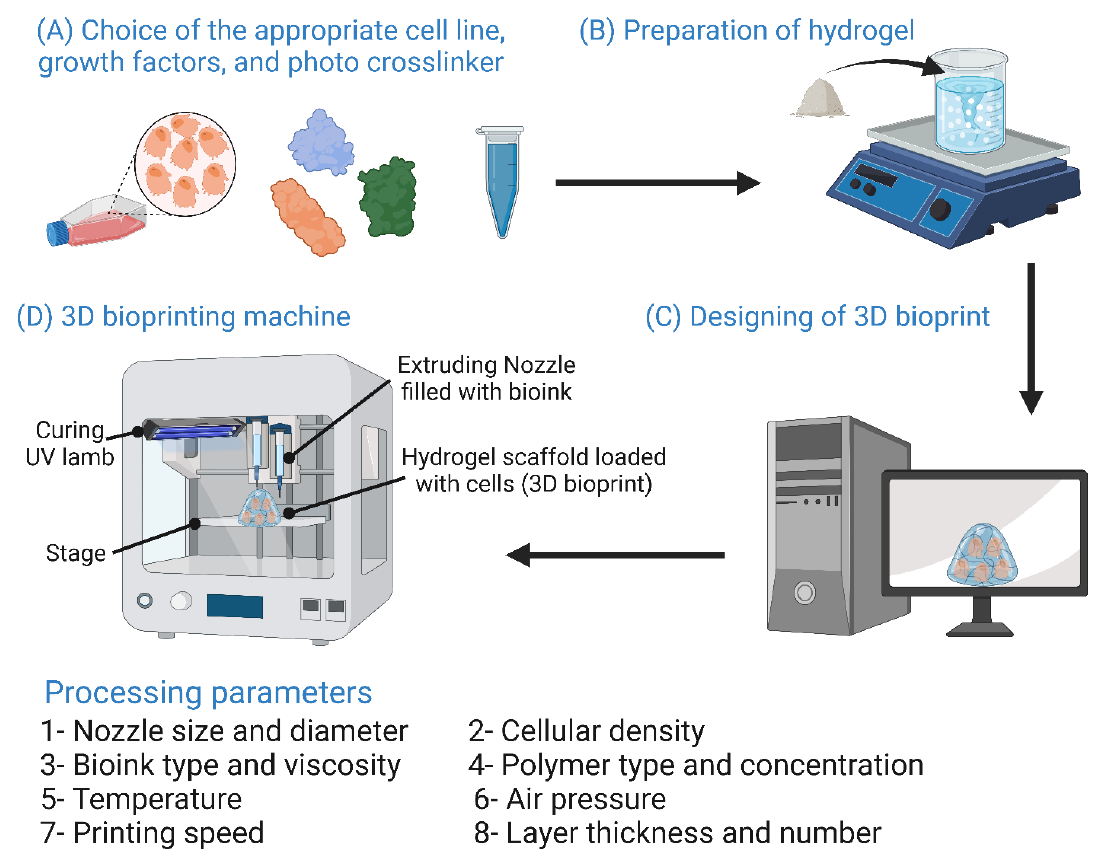
Figure 17. The 3D bioprinting technique and its processing parameters and additives. The image was created using Biorender.